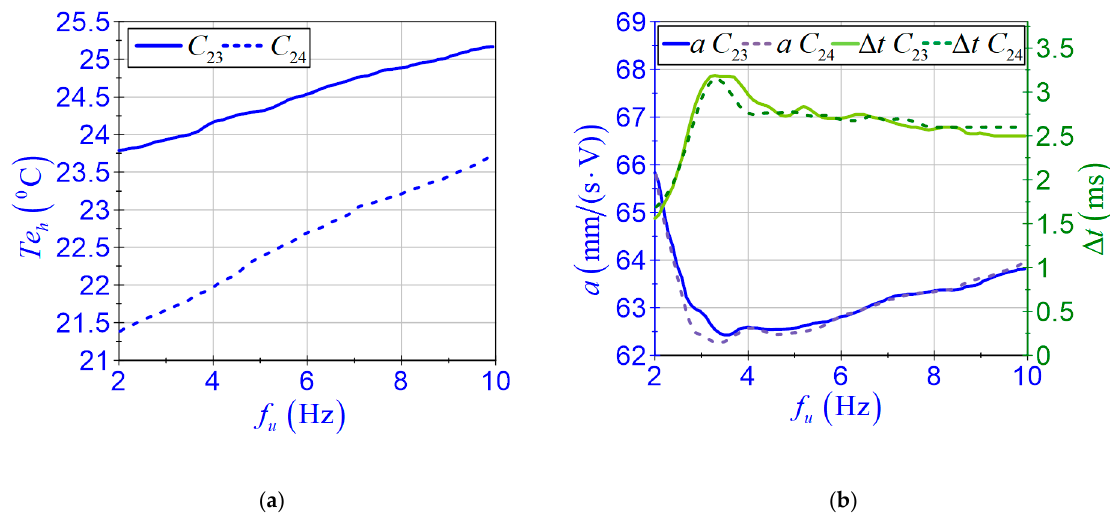
Figure 11. ( a ) Mean value of harvester housing temperature Te h vs. frequency f u ; ( b ) gain a and time shift coefficient ∆ t vs. frequency f u .